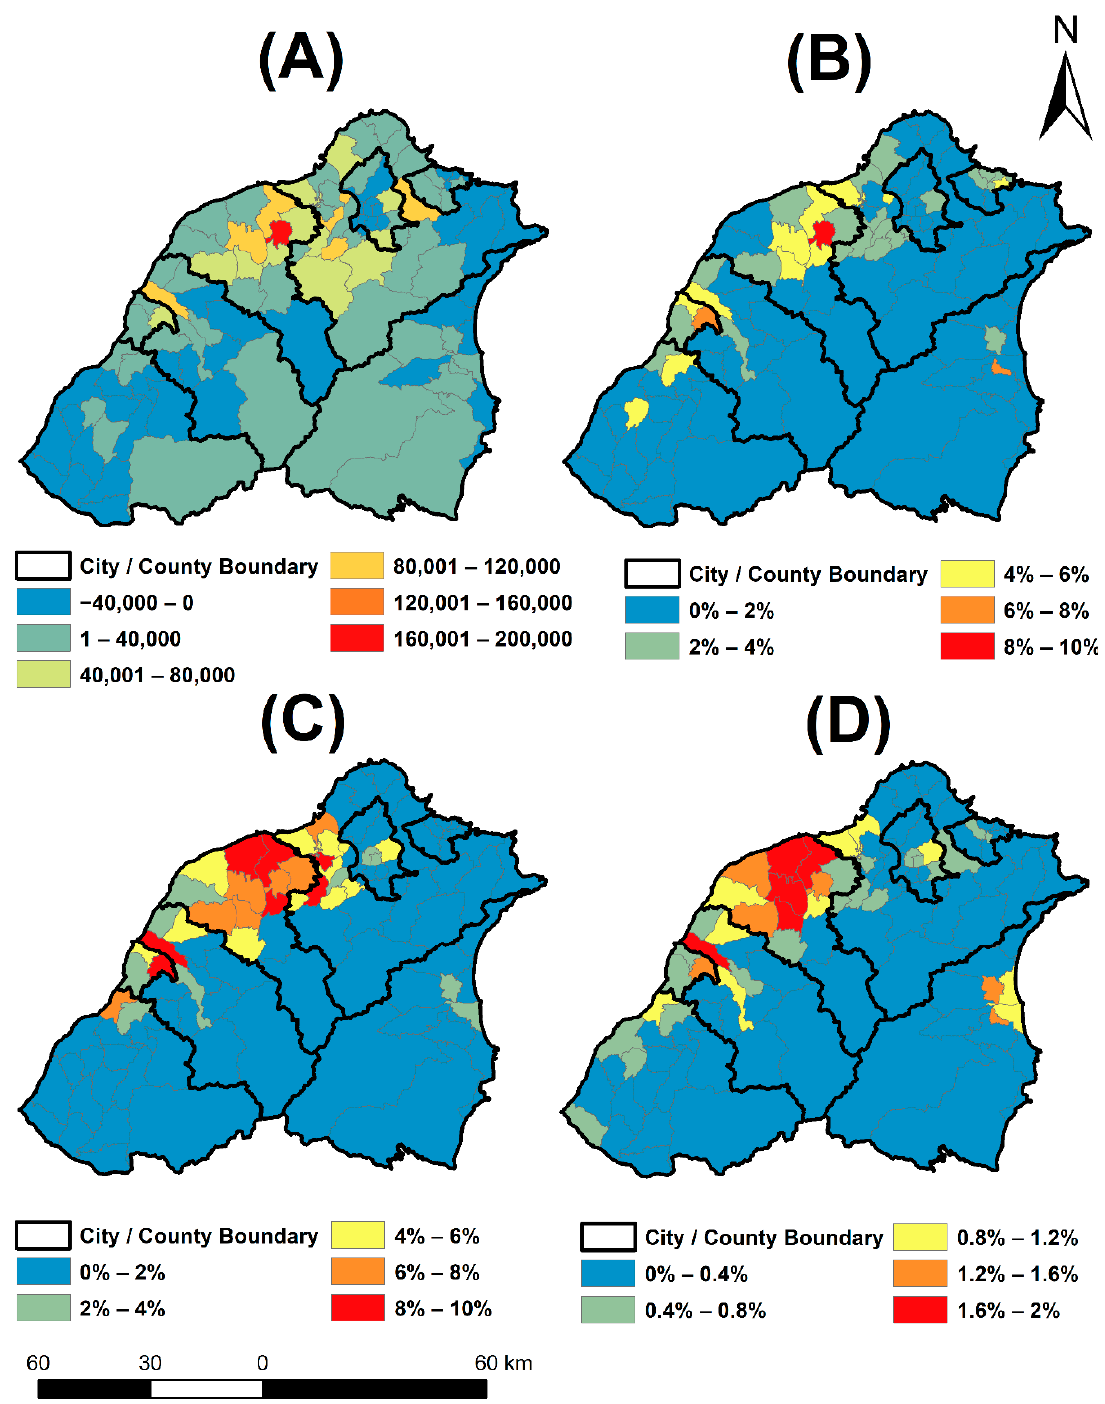
Figure 4. Equal interval choropleth maps of population count and land use (Residential, Employment, and Transportation) change (in % of district size) from 1991 to 2015. ( A ) population count change; ( B ) residential land use change; ( C ) employment land use change; and ( D ) transportation land use change.